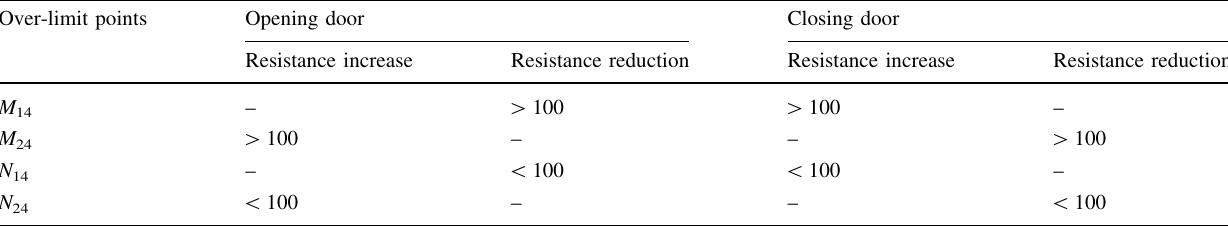
Table 4 Rules for slight resistance change in whole process